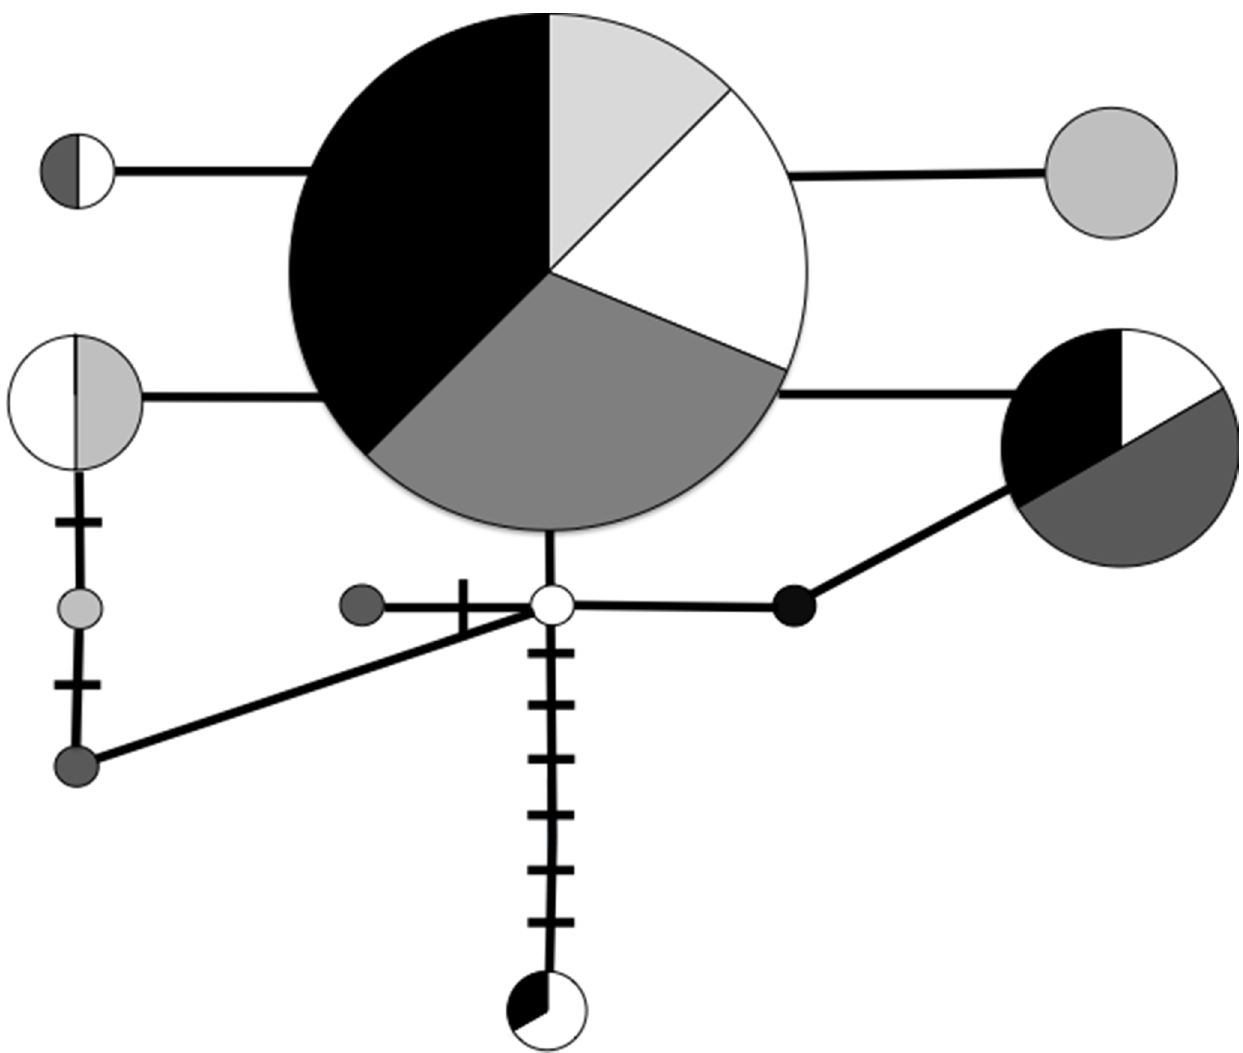
Figure 3. Network of 11 mitochondrial haplotypes of western tent caterpillars from Galiano and Westham Islands based on the intergenic spacer region and partial sequences of cytochrome oxidase I. Individuals from Galiano Island 2003 and 2011 are represented by light gray and white and those from Westham Island 2003 and 2011 are represented by dark gray and black, respectively. The size of each circle is proportional to the number of individuals. Lines connecting each haplotype correspond to a single nucleotide change and black lines represent a single unobserved nucleotide change between haplotypes inferred from parsimony analysis.